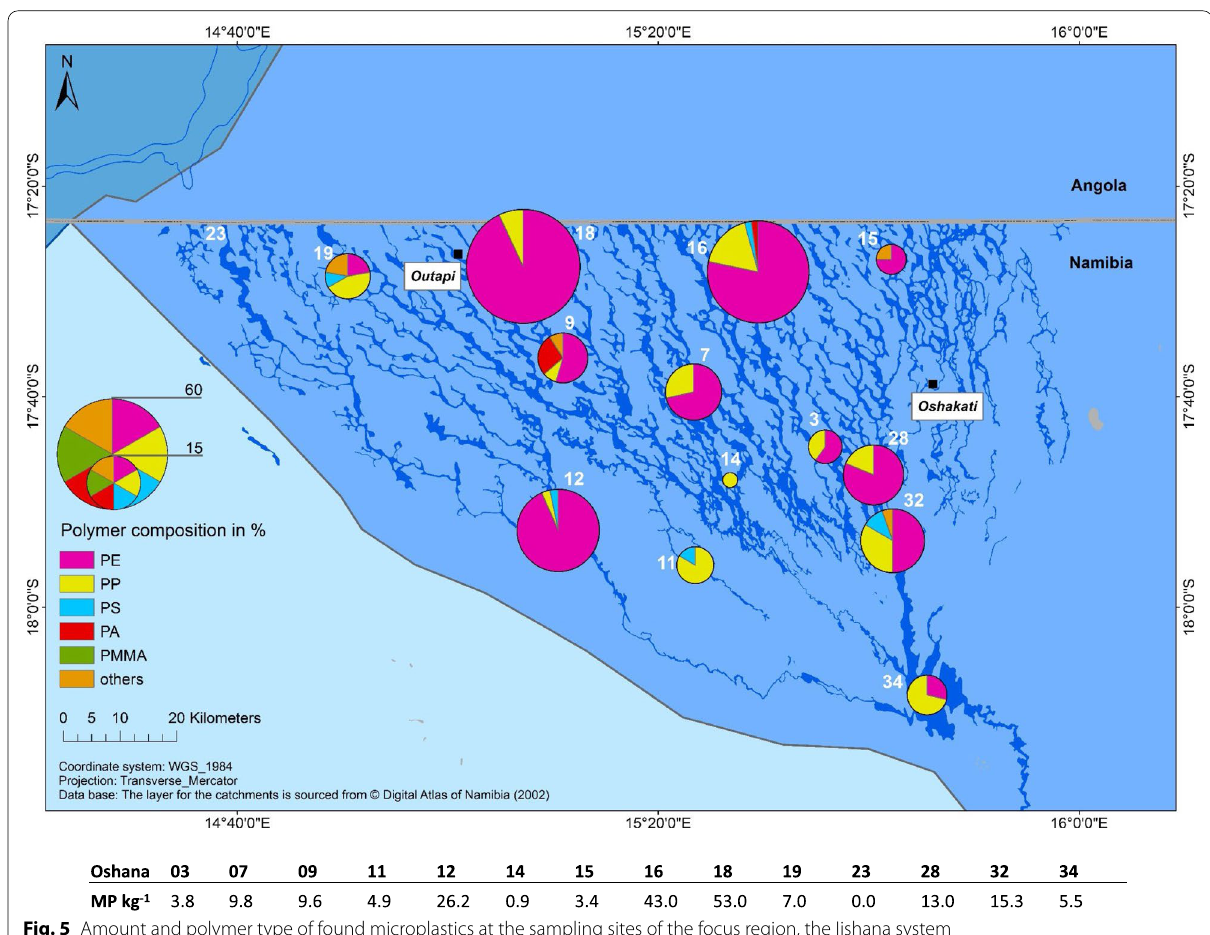
Fig. 5 Amount and polymer type of found microplastics at the sampling sites of the focus region, the Iishana